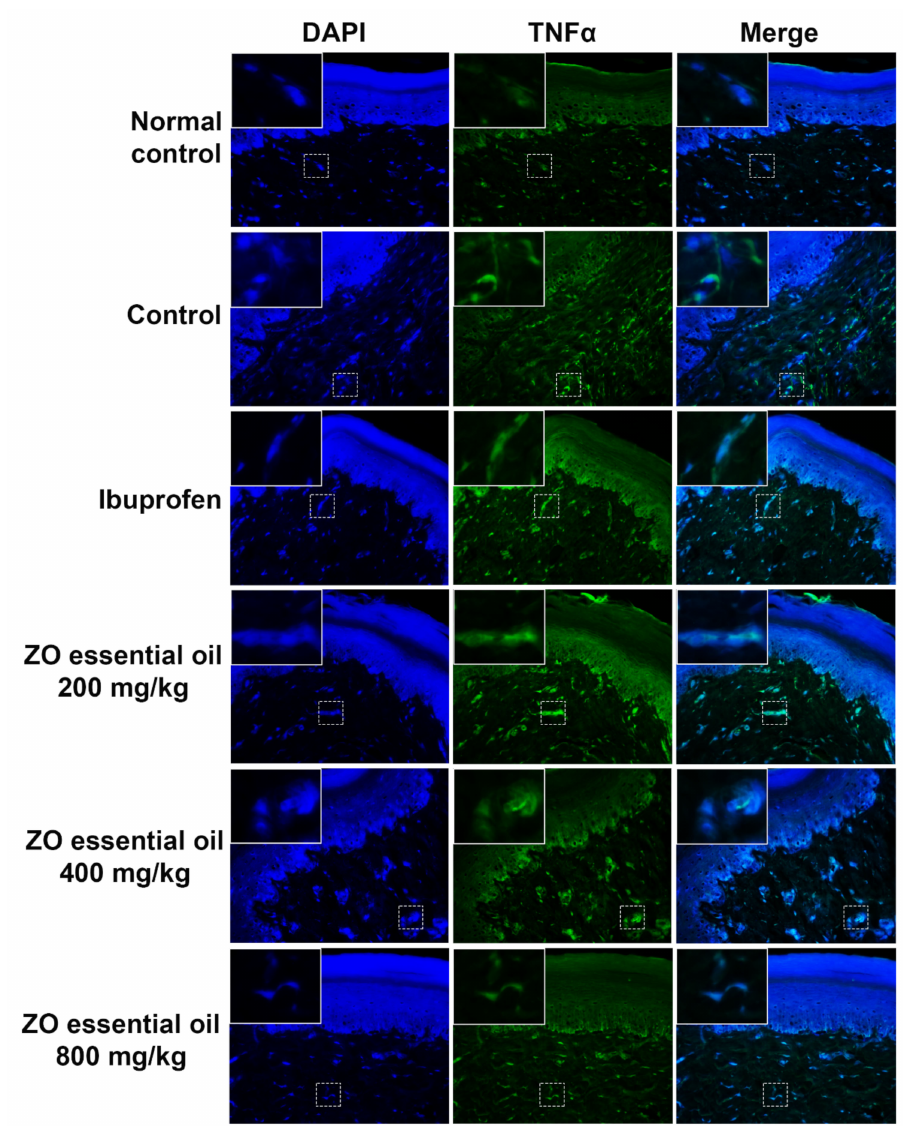
Figure 7. Immunofluorescence study for TNF- α expression in paw tissue of rats, pretreated with vehi- cle (0.9% saline), ibuprofen (100 mg/kg), or ZO essential oil at different doses, at 6 h after carrageenan injection. Micrographs were photographed by a fluorescence microscope (400 ×